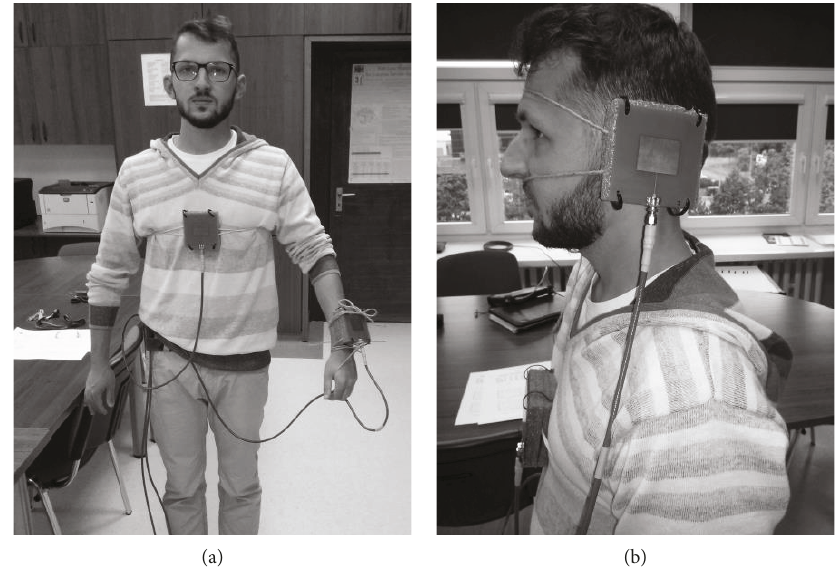
Figure 3: Exemplary placements of receiving antennas for con fi gurations C2 (a) and C4 (b).